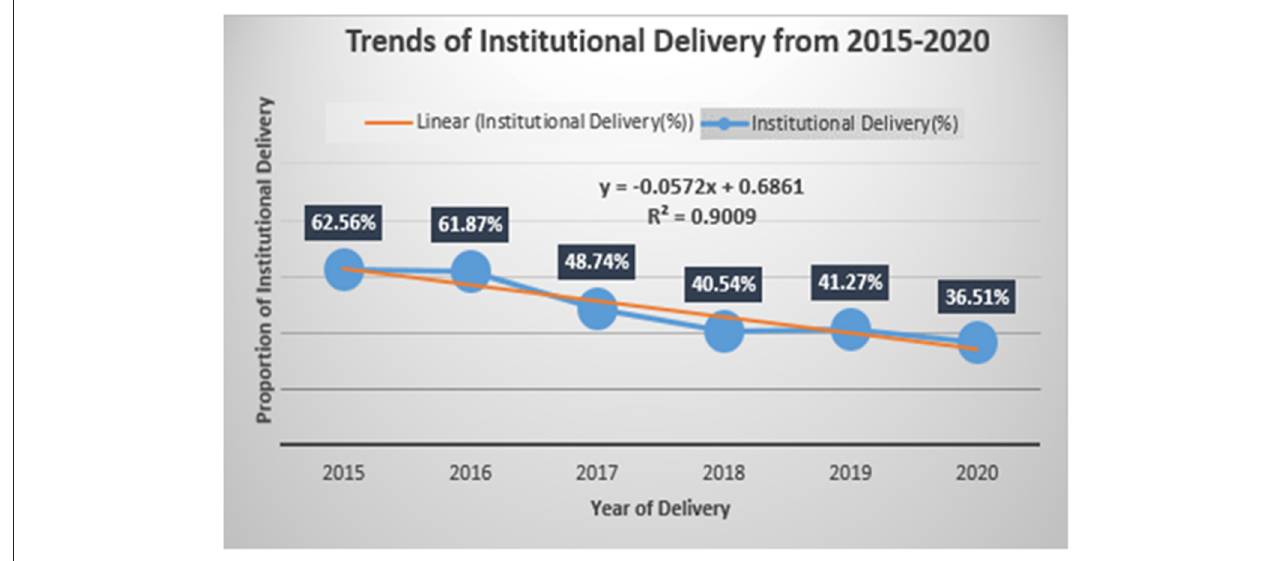
FIGURE 1 | Trends of institutional delivery in Kersa HDSS,